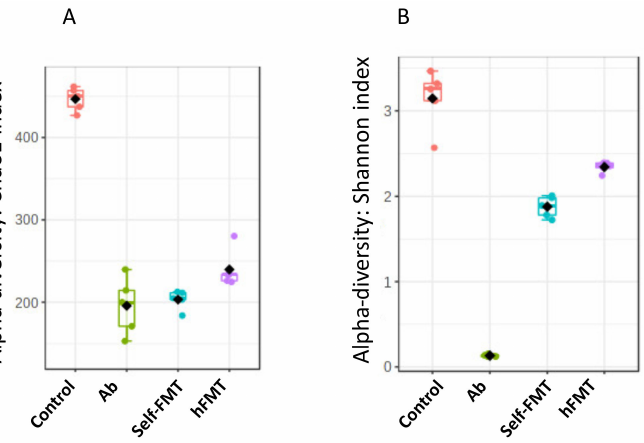
Figure 3. Changes in intestinal bacterial richness and diversity . Microbial α -diversity. ( A ) Micro- bial richness (Chao1) and ( B ) diversity (Shannon) indexes are shown. Ab, antibiotic; hFMT, human fecal microbiota transplantation; self-FMT, self-fecal microbiota